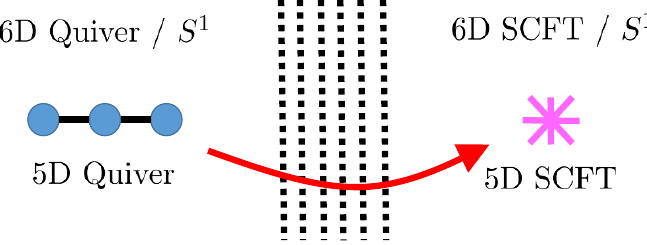
Figure 1 . Depiction of the phase structure for 6D theories reduced on a circle. Reducing a (1 ; 0) 6D SCFT leads to a 5D SCFT, as indicated on the right. A sequence of (cid:13)op transitions in the extended K(cid:127)ahler cone of the Calabi-Yau threefold connects this chamber of moduli space to the one obtained by dimensional reduction of the generalized 6D quiver. This leads to a generalized 5D quiver, which need not possess a (cid:12)xed point in this chamber of moduli